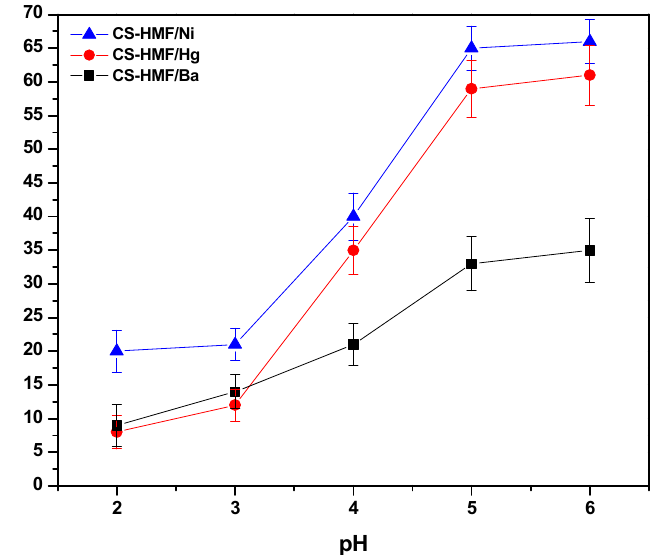
Figure 2. pH effect on the uptake of Ni 2+ , Hg 2+ , and Ba 2+ , from aqueous solutions (single-component) by using CS-HMF adsorbent.